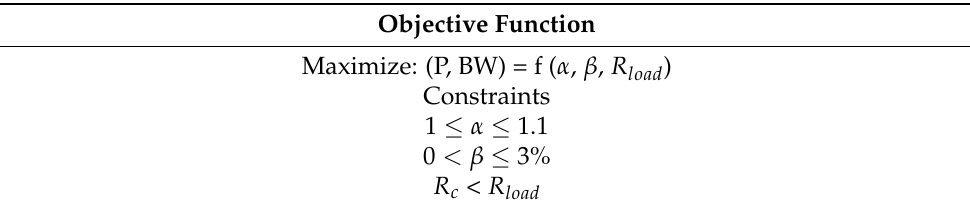
Table 2. Objective function and constraints applied to the optimization problem for the 2-DOFs harvester.